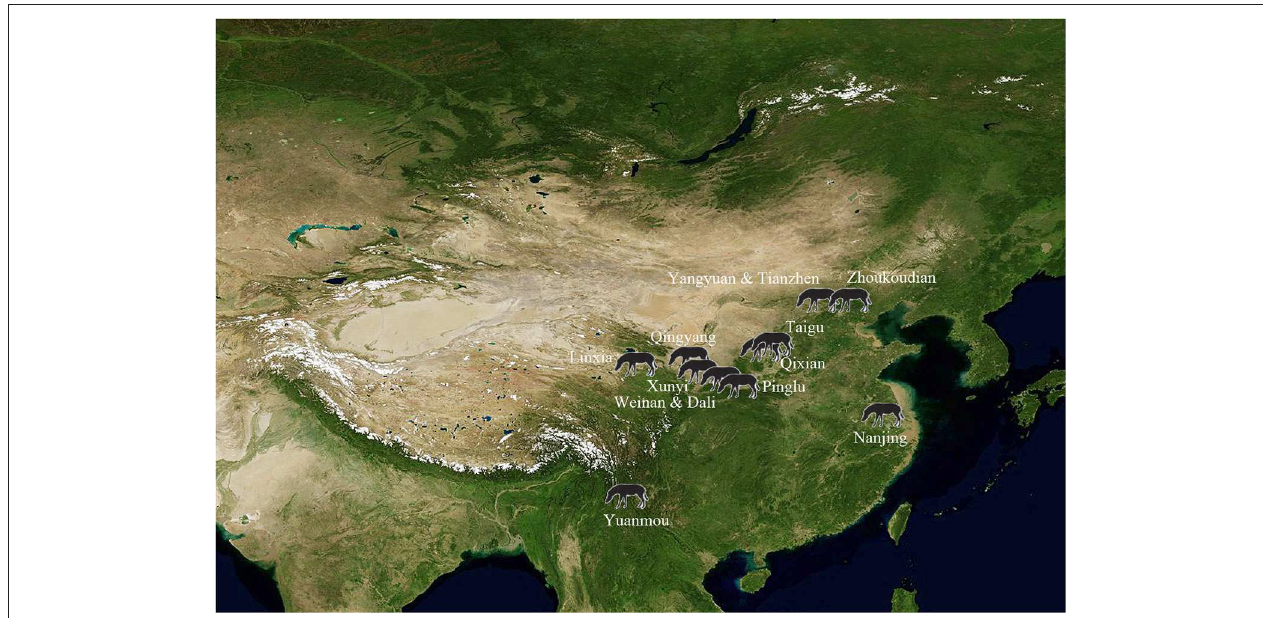
FIGURE 2 | Main localities of stenonids in China.